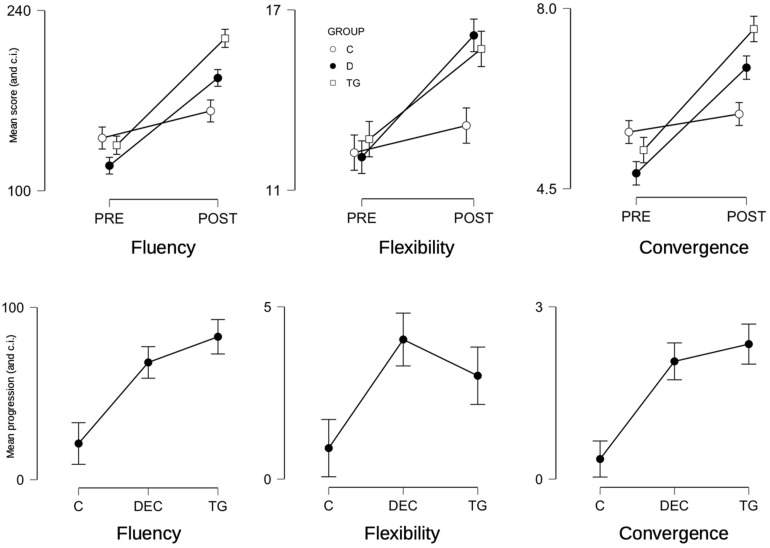
Top row: graphs of interactions between the GROUP and PRE/POST factors on the FLU, FLEX, and CONV variables (and confidence intervals). Bottom row: effect of the GROUP factor on the progression of the FLU, FLEX, and CONV variables (and confidence intervals) between the PRE and POST measures.